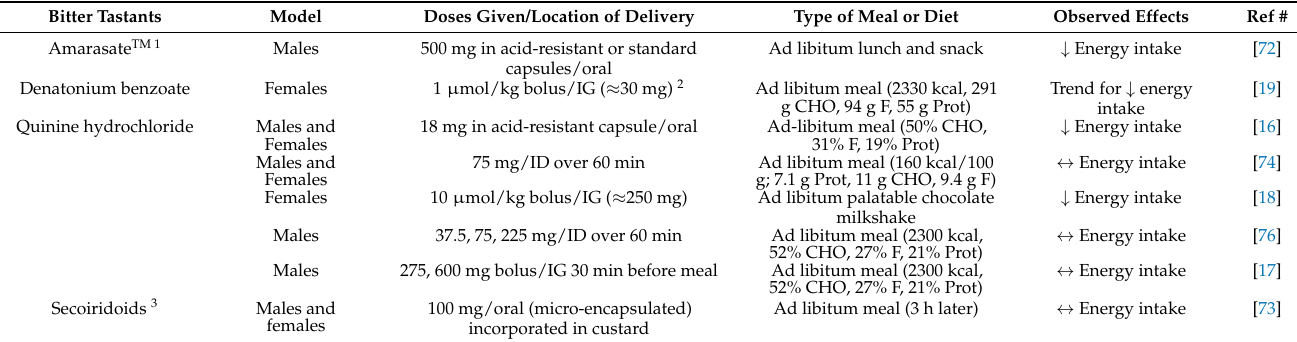
Table 6. Effects of bitter substances on energy intake in healthy